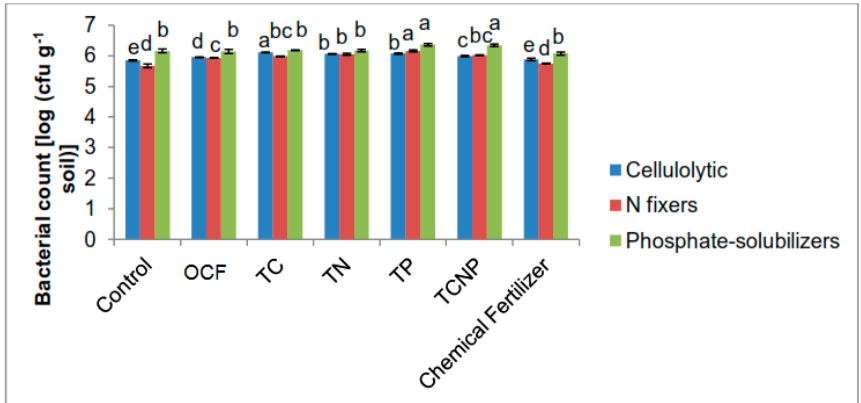
Figure 1. Population of cellulolytic, nitrogen-fixing and phosphate-solubilizing bacteria in the rhizosphere of maize at thirty days after sowing. Different letters for similar colored bars indicate significant difference between treatment means using Tukey’s test at P ≤ 0.05.